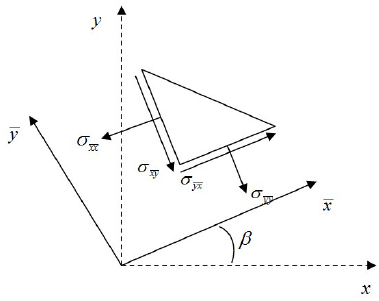
Figure 6. Transformation of